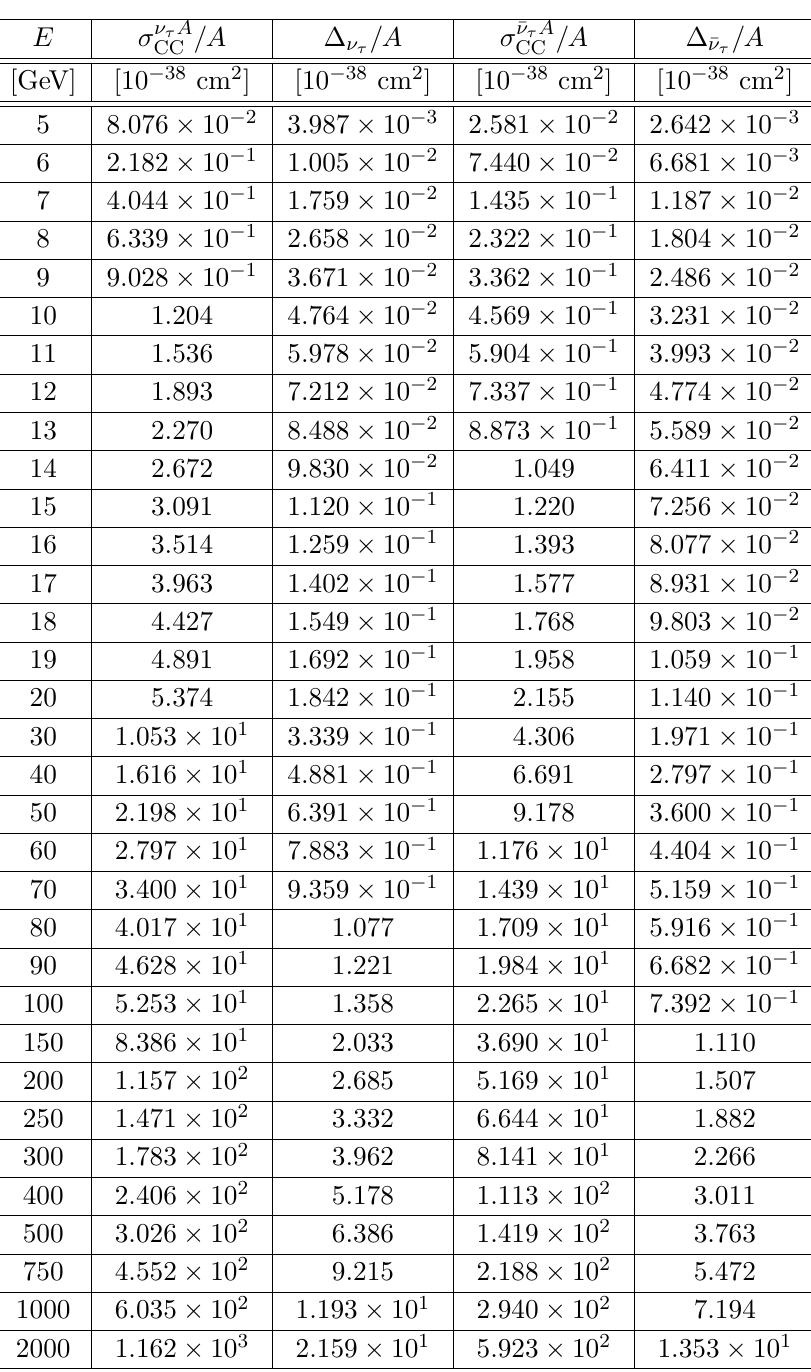
Table 11. The ν τ and ¯ ν τ charged current cross section per nucleon for interactions with tungsten, evaluated using the nCTEQ PDFs. The PDF error is also shown, where ( σ CC ± ∆) /A represents the PDF error band for a tungsten target. Tables for incident tau neutrino and antineutrino energies between 5 GeV and 5 TeV are available assupplementary material attached to this